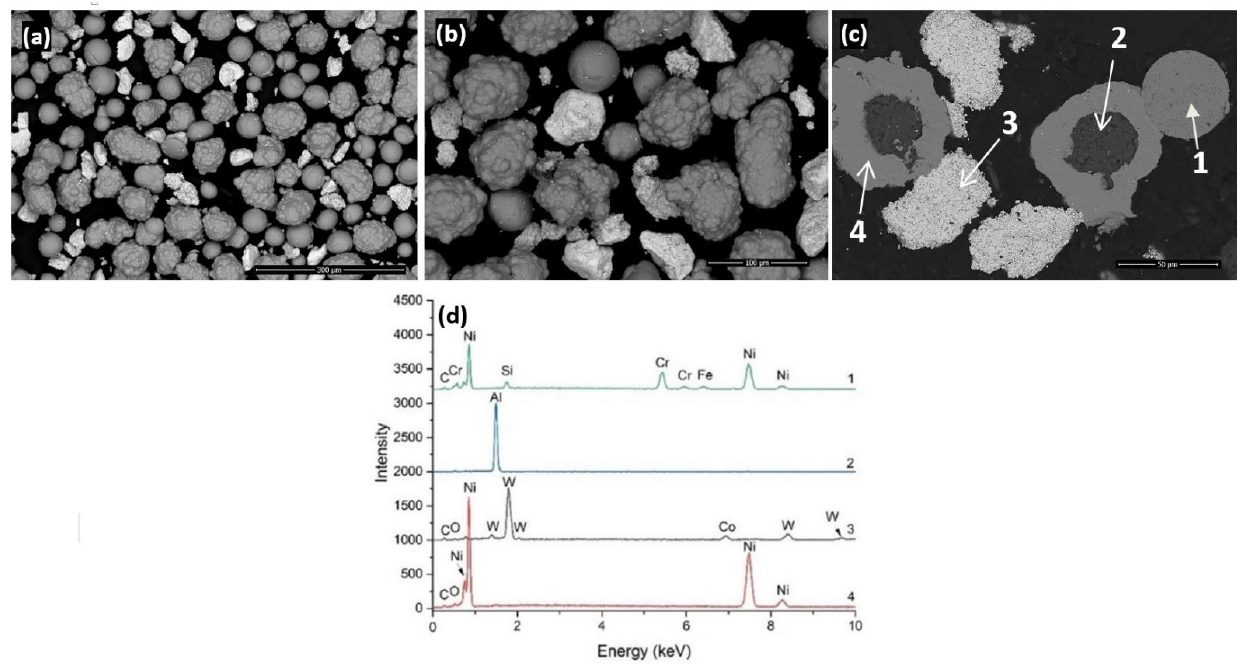
Figure 1. Back scattered electron micrograph of Metco 439 NS powder ( a ) and ( b ), powder cross-section ( c ) and EDX microanalysis ( d ).